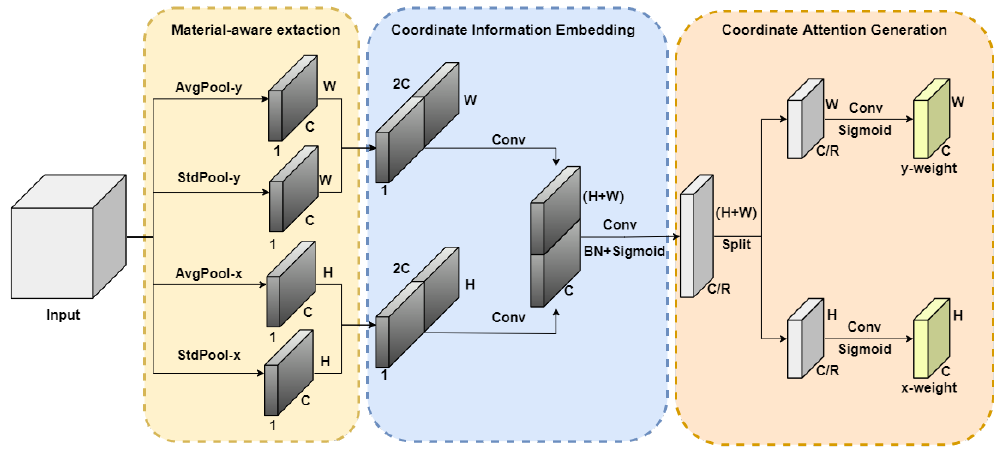
Figure 5. Material-aware coordinate attention (MCA) structure diagram.